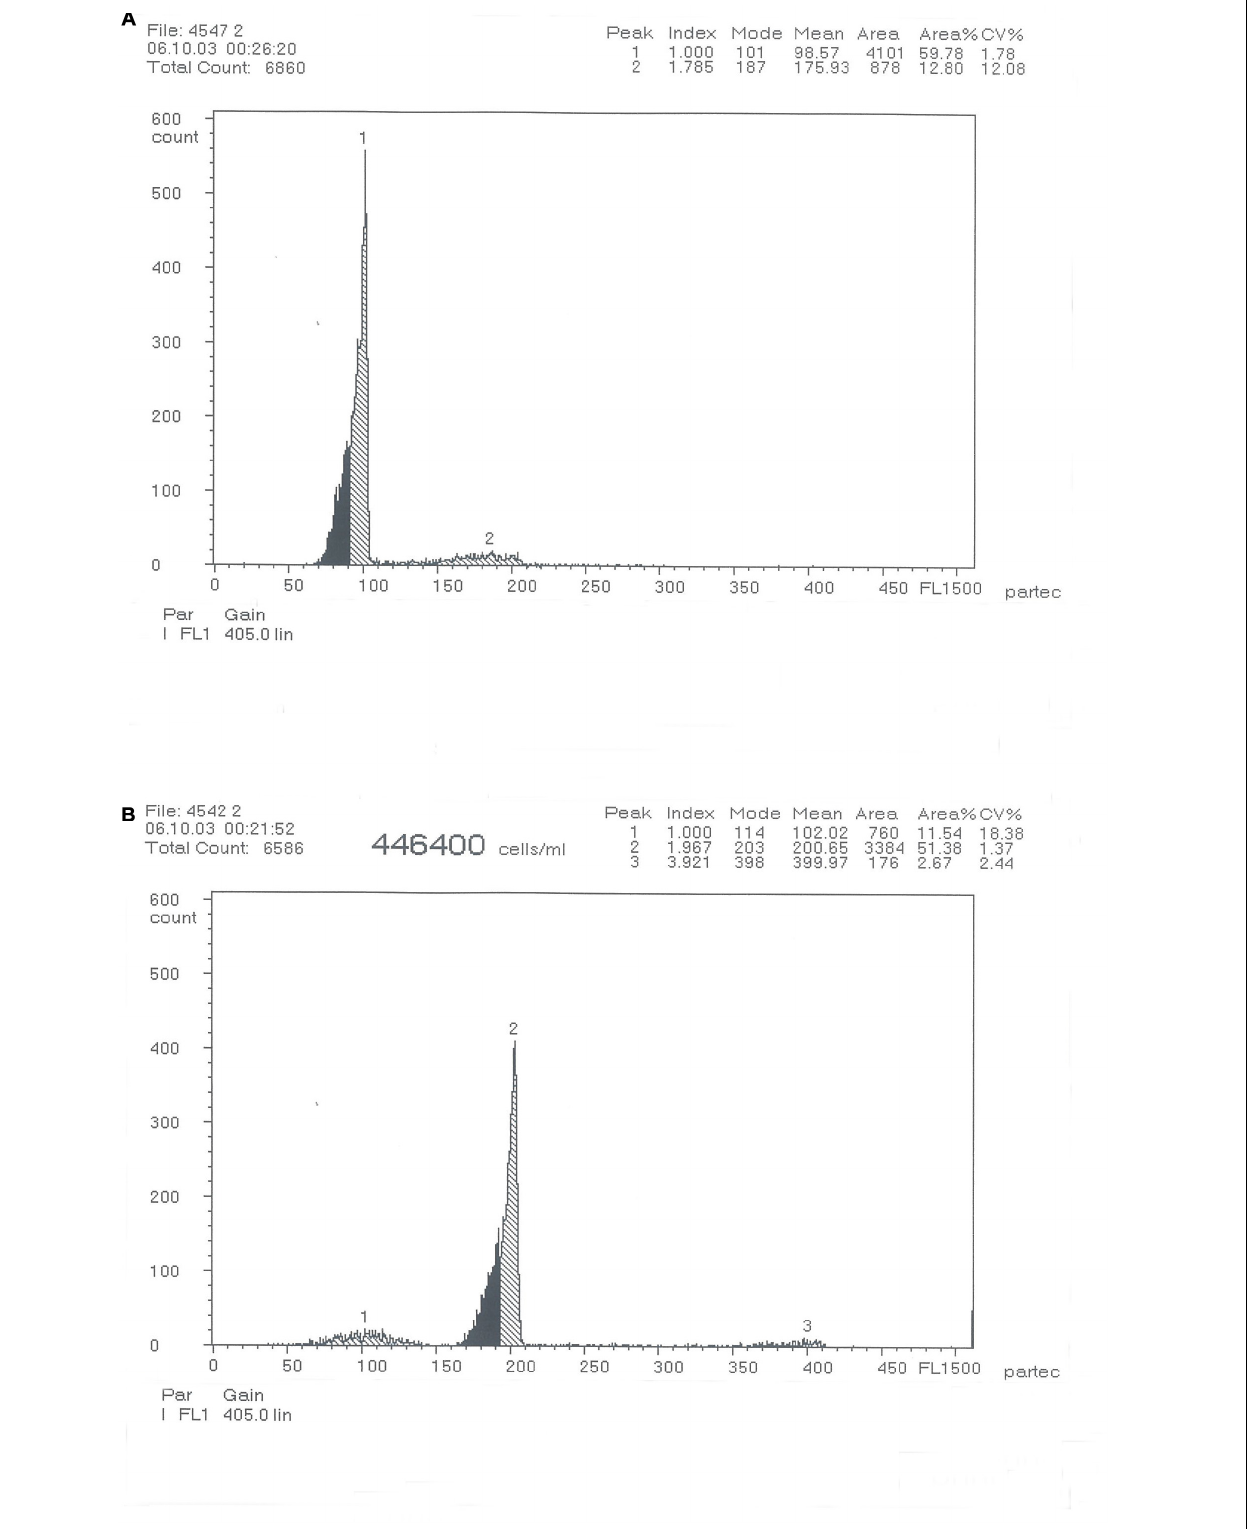
Frontiers in Genetics |